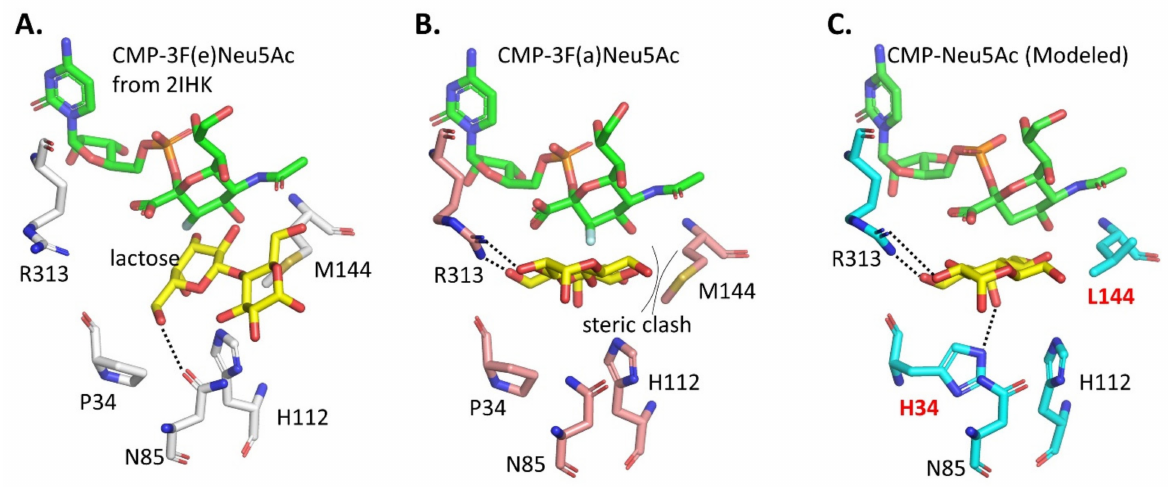
Figure 3. Rational engineering of PmST1 to change its regioselectivity. PmST1 exhibits both α 2,3 and α 2,6 SiaT activity. The structure of PmST1 bound to a donor analog and an acceptor suggests a design strategy to change the preferred regioselectivity of the reaction. ( A ). A ternary structure of PmST1 bound to the donor analog, CMP-3F(e)Neu5Ac, containing an equatorial fluorine at C3, and lactose was modeled from 2IHK (a binary structure of PmST1 bound to CMP-3F(e)Neu5Ac) and 2ILV (ternary structure of PmST1 with CMP and lactose). In this position, 3 (cid:48) OH of lactose (yellow) is able to attack the anomeric carbon of the donor and form a α 2,3-linked sialoglycan. ( B ). A ternary structure (2IHZ) of PmST bound to CMP-3F(a)Neu5Ac, containing an axial fluorine at C3, and lactose suggests a possible pre-catalysis complex that would lead to an α 2,6 linkage. The bidentate hydrogen bonds from R313 stabilizes the bound acceptor, but M144 may create a minor steric clash with the galactopyranose ring of lactose. ( C ). The reaction may be biased toward α 2,6 sialylation by favoring the orientation of lactose found in 2IHZ. Two mutations (red), P34H and M144L (or M144A), can simultaneously stabilize the acceptor through a new hydrogen bond with H34 (dotted line) and reduced steric clash. This structure was generated from 2IHZ by replacing 3F with hydrogen and introducing the mutations in PyMol before energy